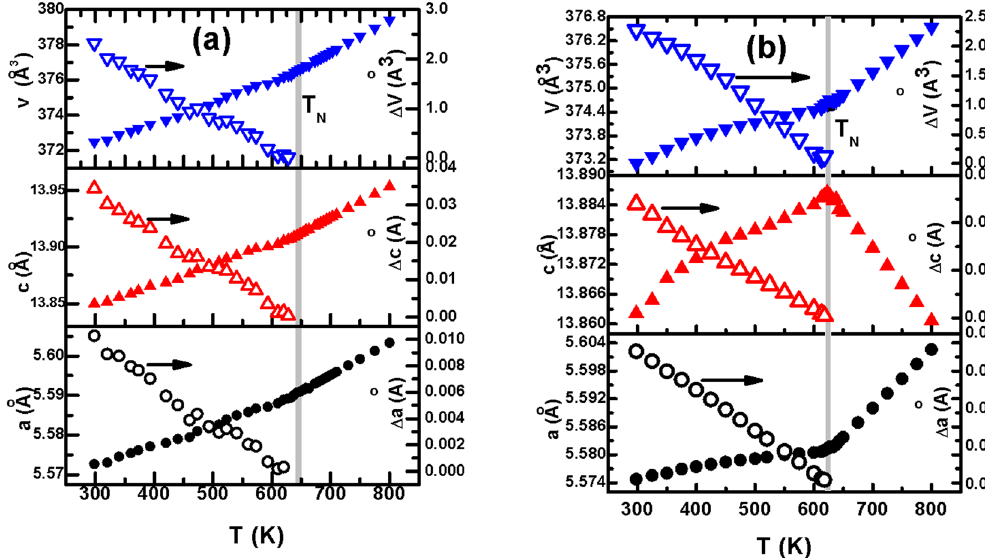
Figure 1. Variation of lattice parameters and volume with temperature for ( a ) bulk and ( b ) nanoscale ( ∼ 20 nm) BiFeO 3 ; estimated standard deviation obtained from the refinement varies within 0.2–0.4% for the lattice